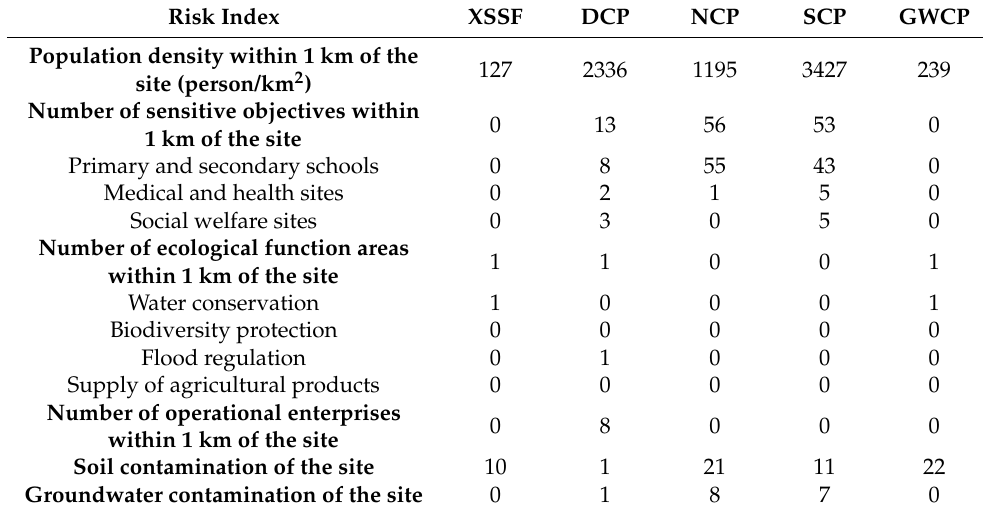
Table 3. The results of the risk identification analysis of the contaminated